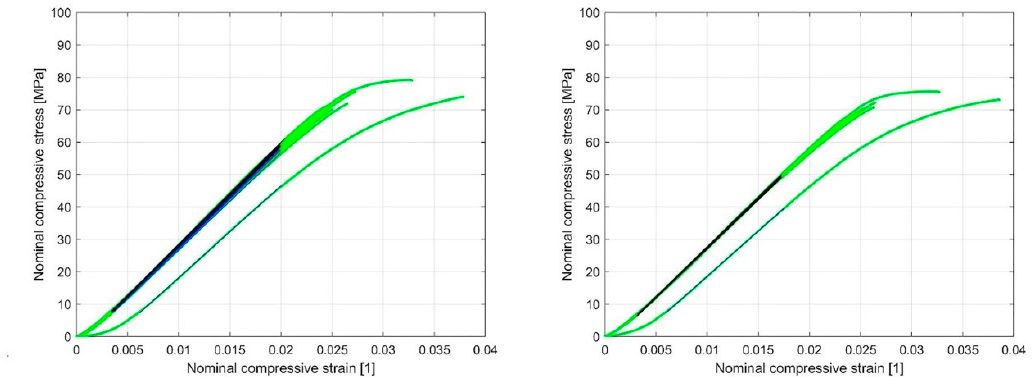
Figure 19. Nominal compressive stress–nominal compressive strain diagram with the linear region of the curve highlighted for 1.6 mm (left) and 2.4 mm (right) ILD (initial nominal displacement 0.4 mm).